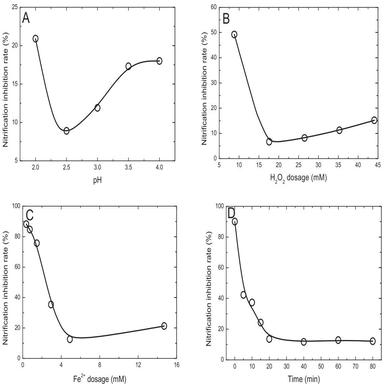
Effect of pH (A), H2O2 (B) and Fe2+ dosage (C), and reaction time (D) on nitrification inhibition rate of Fenton-pretreated wastewater.